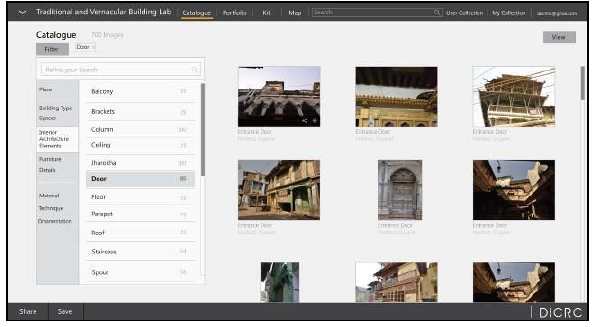
Figure 16. Search filters for the catalogue